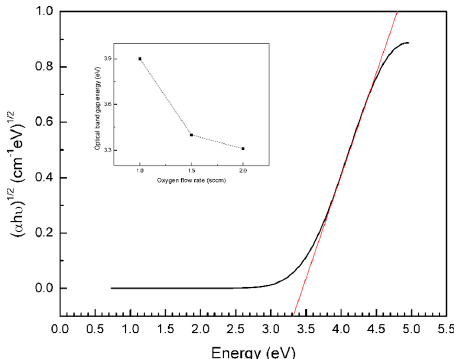
Figure 8. Tauc plot for indirect transitions for a TiO 2 thin film deposited under Ar:O 2 =30:2 sccm flow rate. Inset represents the plot of the optical band gap energy as a function of O 2 flow rate during deposition.